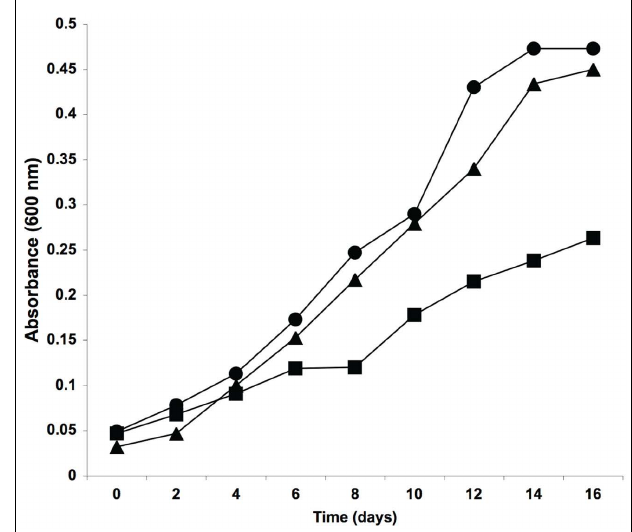
FIGURE 7 | Reduced in vitro growth of Δ esxKL mutant. Cultures were grown in M7H9 broth supplemented with 0.05%Tween and OADC and optical density measurements taken at 600nm. Circles indicate optical density for wild-type, squares for Δ esxKL mutant, and triangles for esxL complemented mutant strain.The reduced growth rate of the mutant was restored to wild-type levels by complementing with esxL . A representative of three experiments is